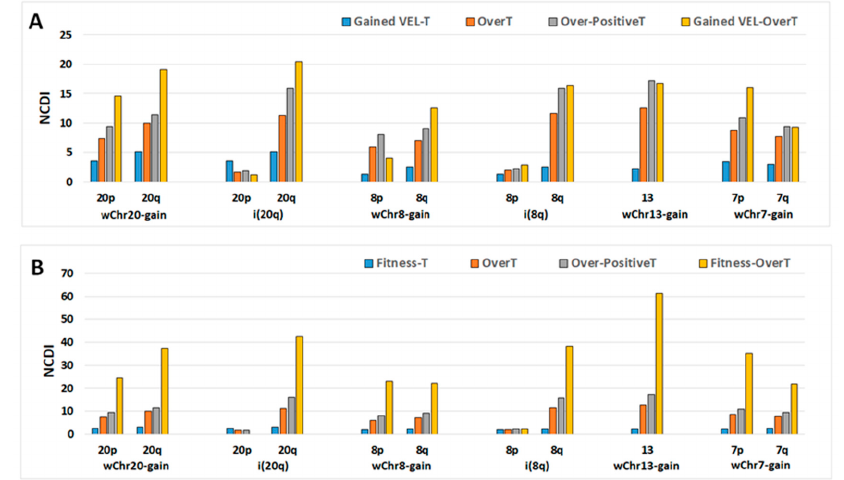
Figure 8. NCDI values of Gained Variant Enhancer Loci-Transcripts (VEL-T), OverT, Over-PositiveT, and Gained VEL-OverT ( A ), and Fitness-T, OverT, Over-PositiveT and Fitness-OverT ( B ) have been calculated in selected chromosomes of each Selected COAD group as indicated in the x